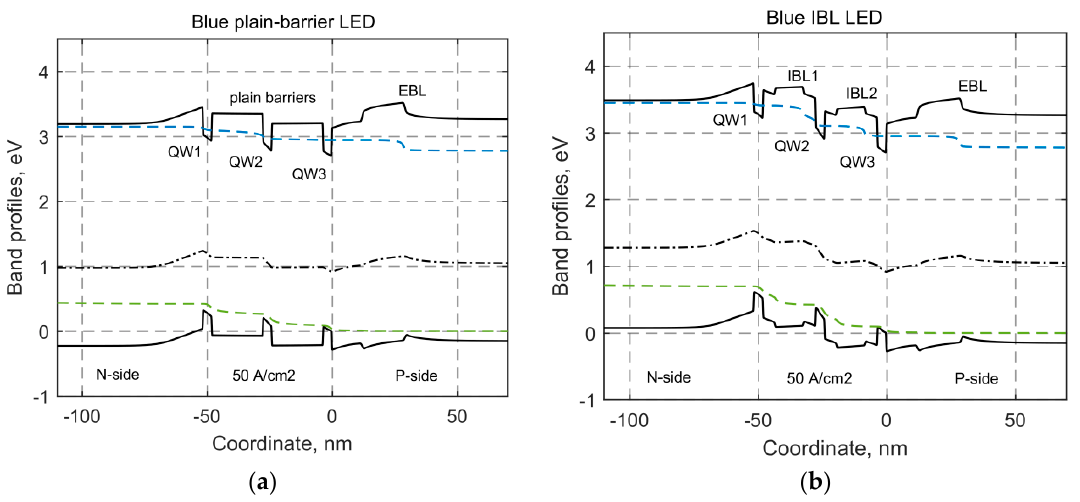
Figure 1. Band profiles of a blue-emitting LED with ( a ) a plain-barrier and ( b ) example intermediate carrier blocking layer (IBL) active region designs calculated at a nominal injection current of 50 A / cm 2 . Dashed lines show the quasi-Fermi levels for electron (blue) and hole (green) drift-diffusion subsystems. The dashed-dotted line represents the internal built-in potential distribution across the active region.